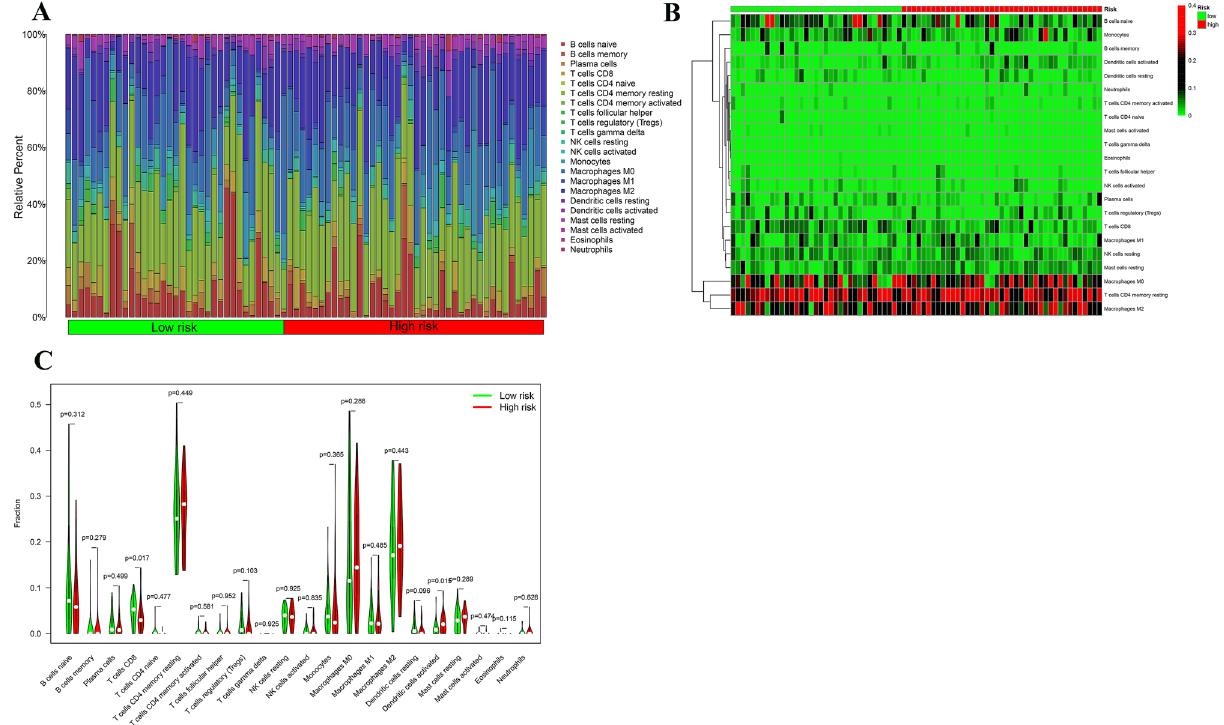
Figure 11. Inference of tumor-infiltrating immune cells. ( A ) CIBERSORT was used to calculate the levels of 22 tumor infiltrating immune cells in PC patients; ( B ) association of risk score and immune cells infiltration; ( C ) differences in the proportion of 22 tumor-infiltrating immune cells between the high and low risk groups (* P < 0.05 ** P < 0.01 *** P < 0.001).